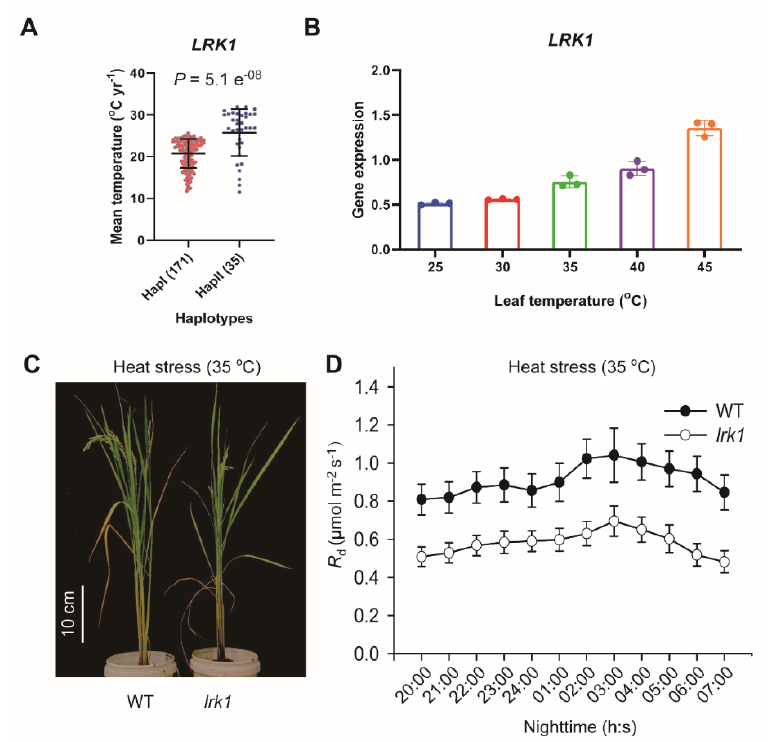
Figure 6. Response of LRK1 rice mutants to heat stress. ( A ) Comparison of haplotypes of LRK1 with the mean annual temperature of the regions from where each accession in the minicore panel was collected. ( B ) Temperature-dependent of LRK1 gene expression levels in 40-day old WT rice plants. Each temperature treatment was applied for 30 min at the leaves level. ( C ) Performance of WT and lrk1 grown in GR exposed to long-term heat stress (35 ◦ C) for 30 days on 30-day old plants. The white vertical scaling bar represents 10 cm length. ( D ) R d dynamics during nighttime for WT and lrk1 mutant measured at the end of heat treatment (60-day old plants including 30 days at normal temperature and 30 days exposure to 35 ◦ C). For panel ( D ) each data point is the average of six di ff erent measurements conducted on six di ff erent plants ±SE.